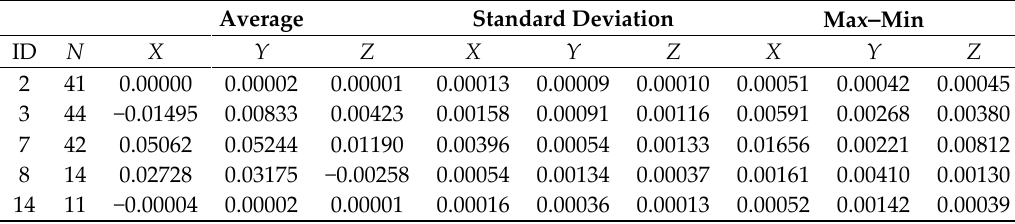
Table 3. Statistical parameters of smartphone gyroscopes bias. Selected devices with more than 10 measurements are presented. Average and standard deviation [rad/s] for the three axes are